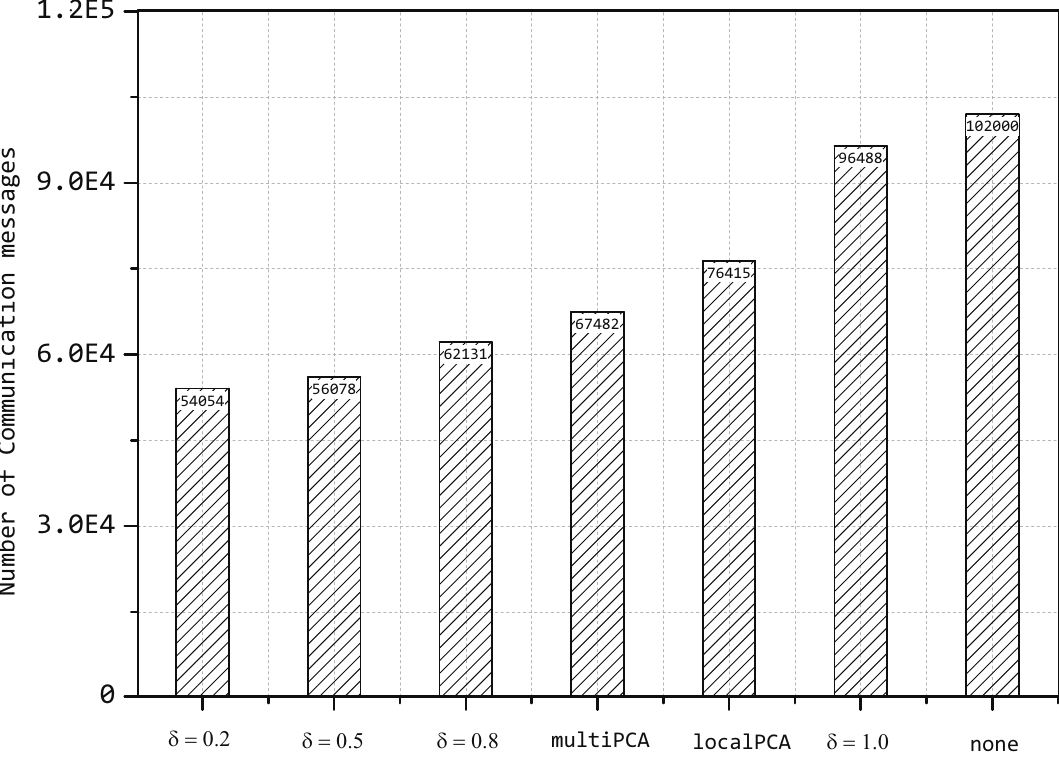
Figure 13. Number of communication messages with different